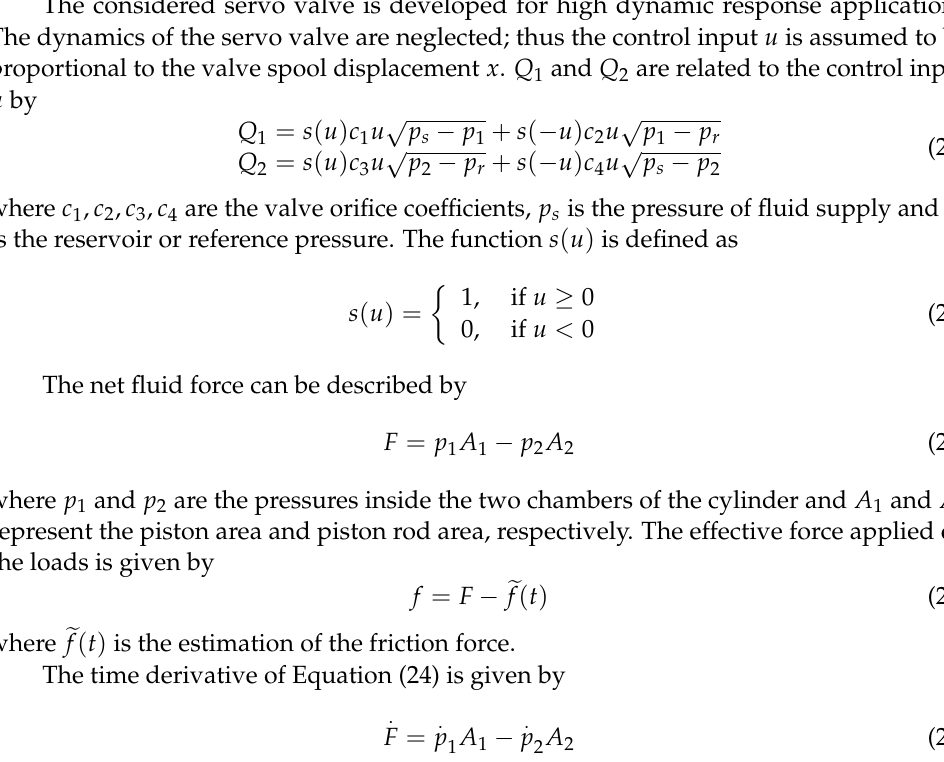
Figure 5. Schematic diagram of the single-rod hydraulic system.